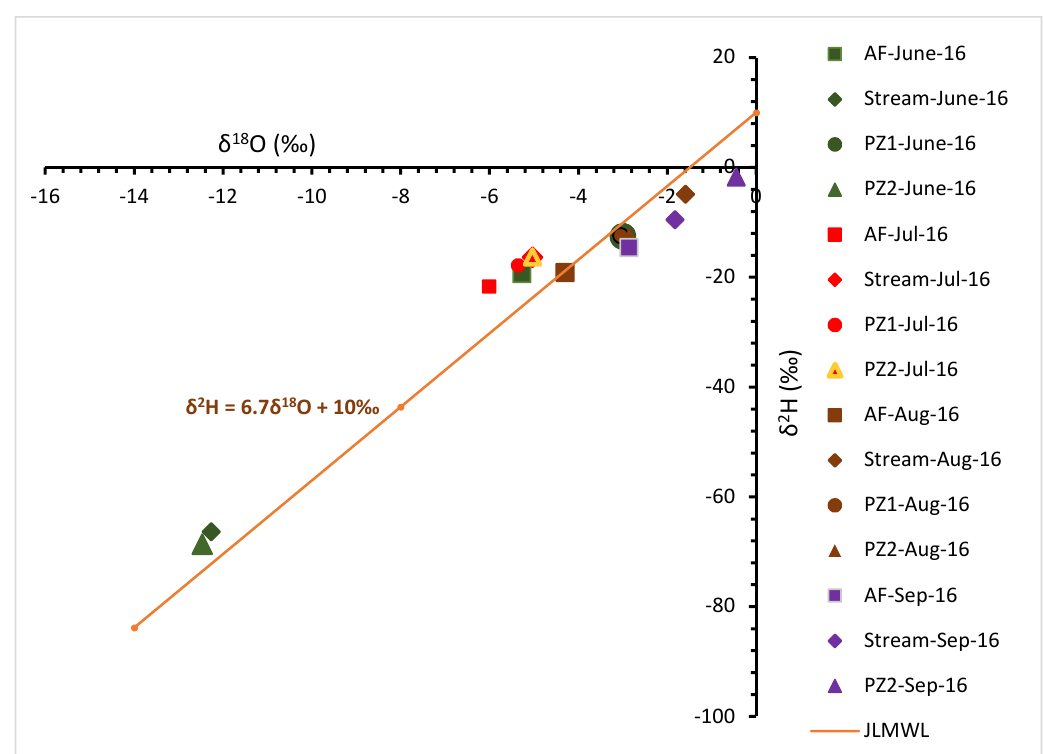
Figure 9. Stable isotope plot of piezometers, Montgomery stream and the selected Albert Farm spring samples plotted against the Johannesburg Local Meteoric Water Line (JLMWL).